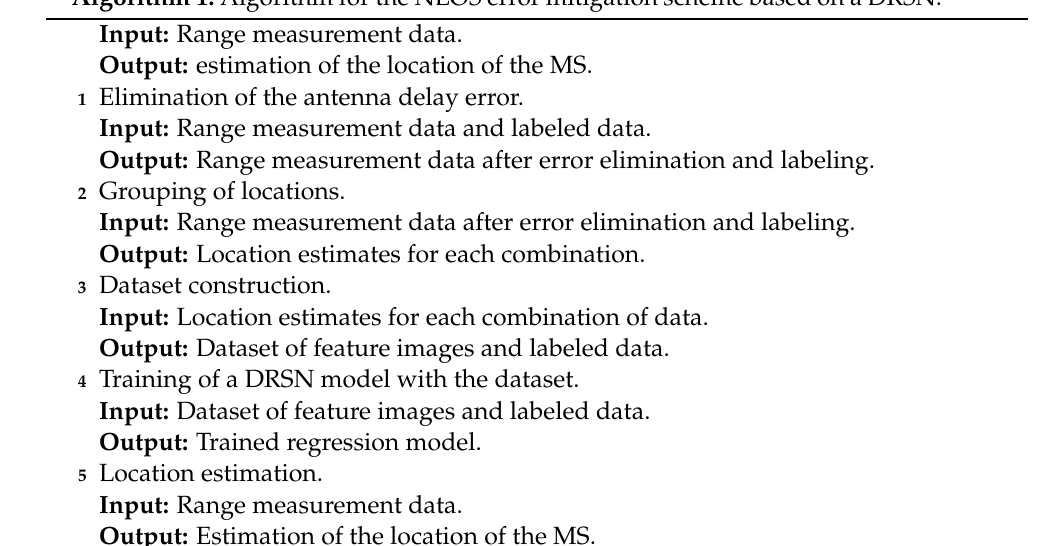
Algorithm 1: Algorithm for the NLOS error mitigation scheme based on a DRSN. Input: Range measurement